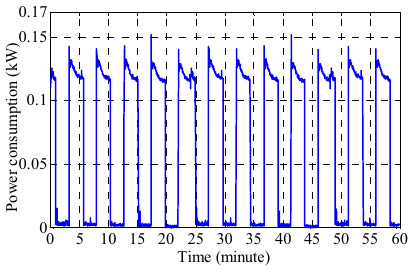
Figure 21. Actual power consumption curve of REF load.